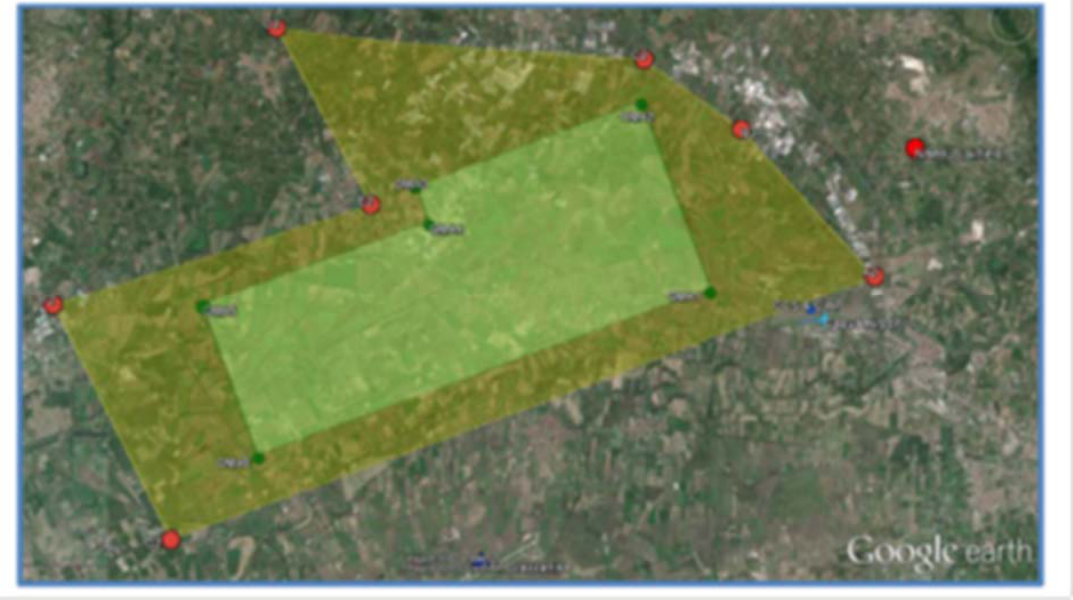
Figure 3. Flight test area with effective operative area (inside) (from [18]); it contains public sector information licensed under the Open Government Licence v3.0, see [22].